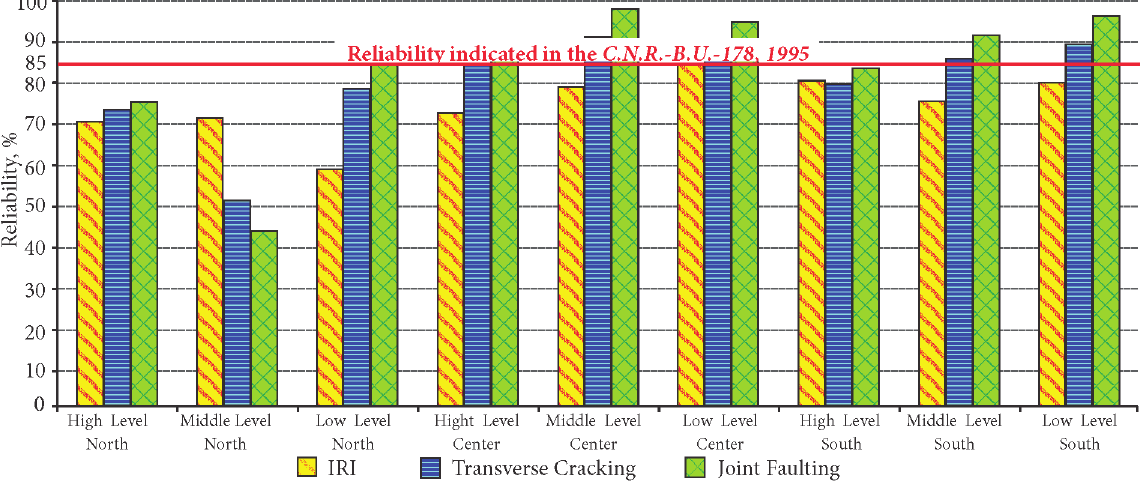
fig. 11. Decay of the pavement – highway/rigid pavement after 20